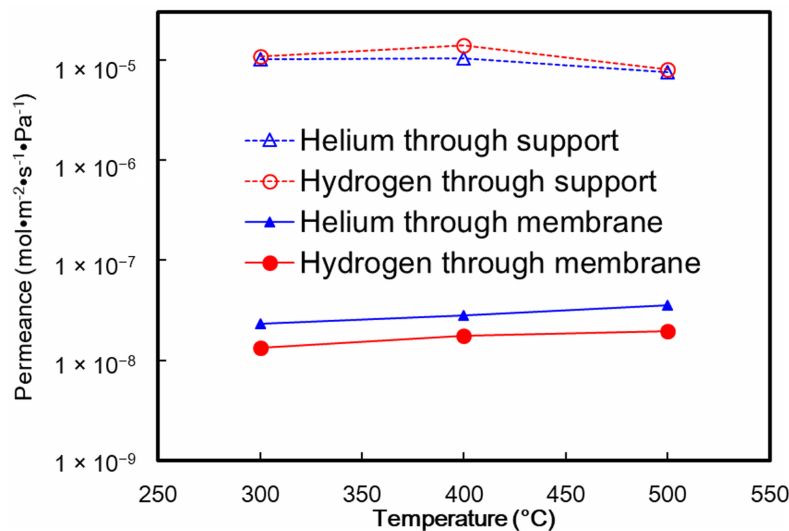
Figure 6. He and H 2 permeances through cobalt oxide silica coated substrate and uncoated substrate as a function of temperature.